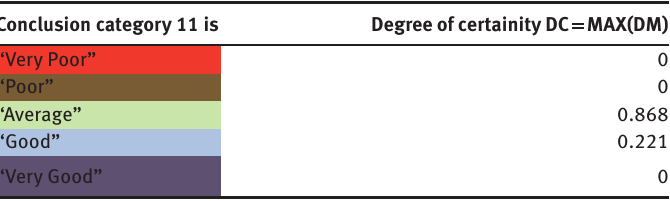
Table 6: Degree of Certainty for Node Category 11 Using DM Values of All Rules.